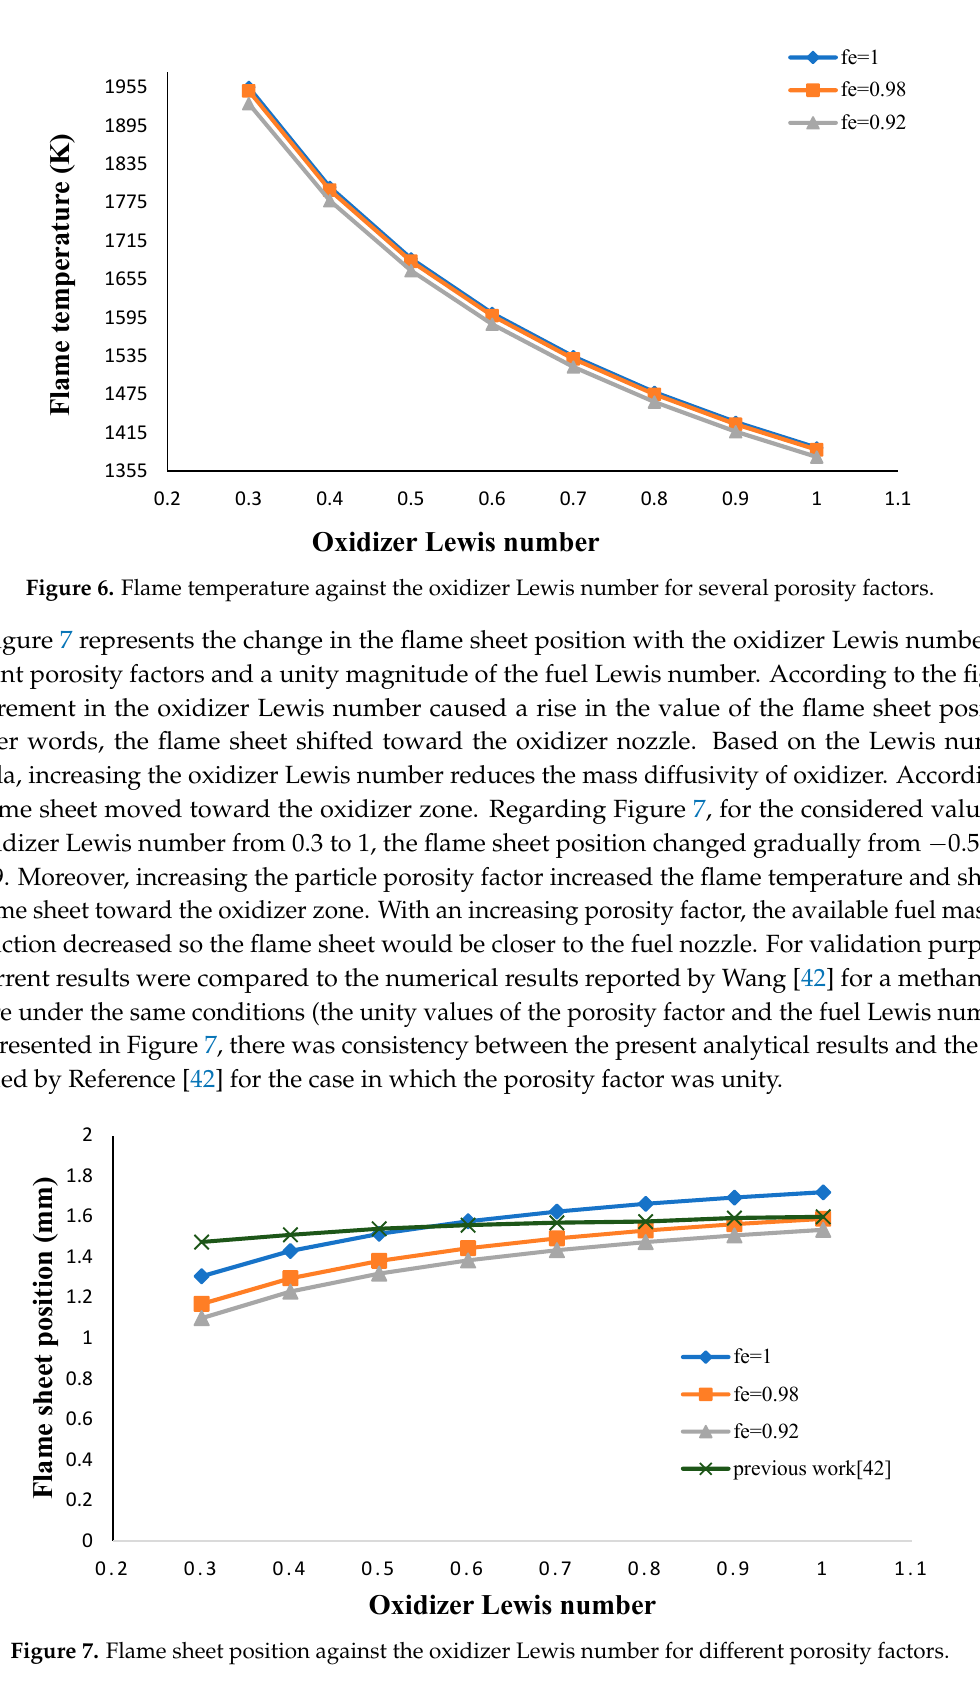
Figure 5. Flame sheet position against the fuel Lewis number for different porosity factors.